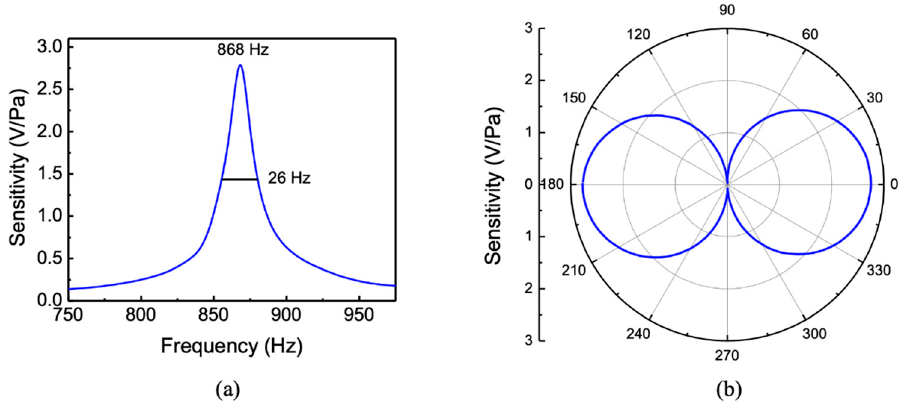
Figure 7. Measured ( a ) frequency response and ( b ) directional response of the sensor in air. The directional response was measured at the peak frequency of 868 Hz.